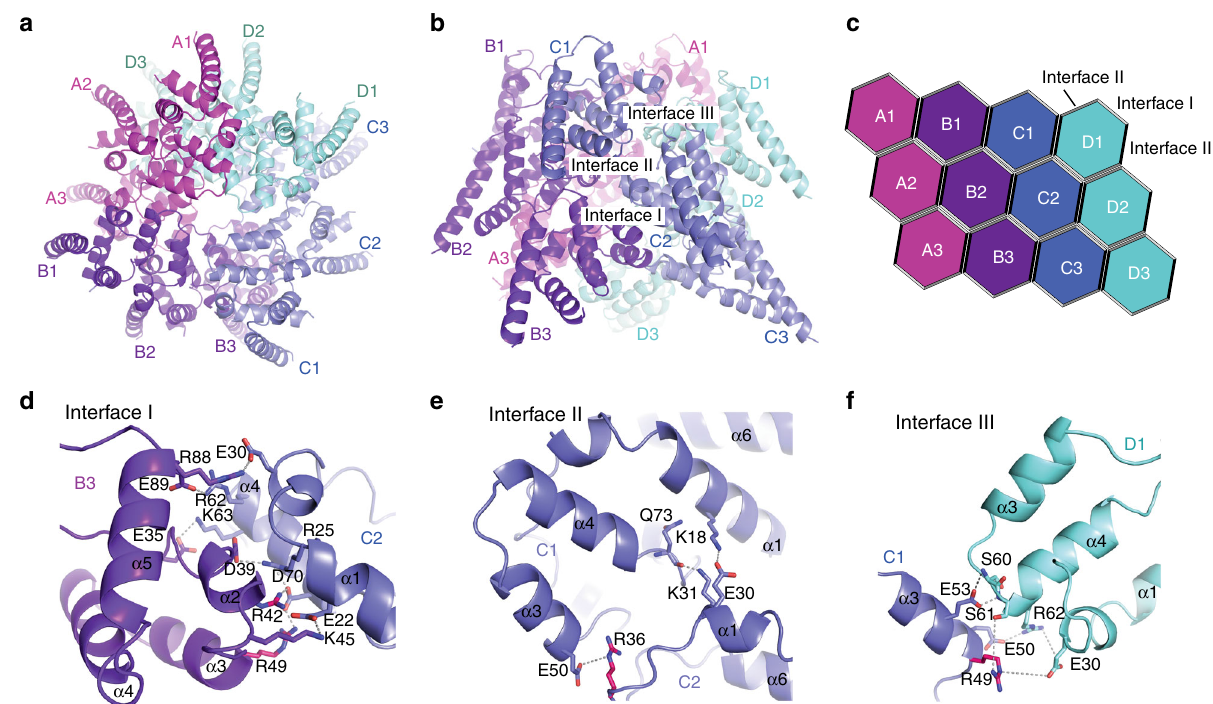
Fig. 2 Core structure of the BCL10 CARD fi lament. a , b Top and side view of the BCL10 protein model obtained by interpretation of the BCL10-MALT1 complex cryo-EM density. c Schematic diagram of the BCL10 helical assembly. Each CARD is represented as a hexagon and the three interfaces are indicated accordingly. d , f Detailed view of the three BCL10 interaction surfaces I ( d ), II ( e ), and III ( f ). Interacting residues are shown in stick representation. Sites mutated R42, R36 are highlighted in